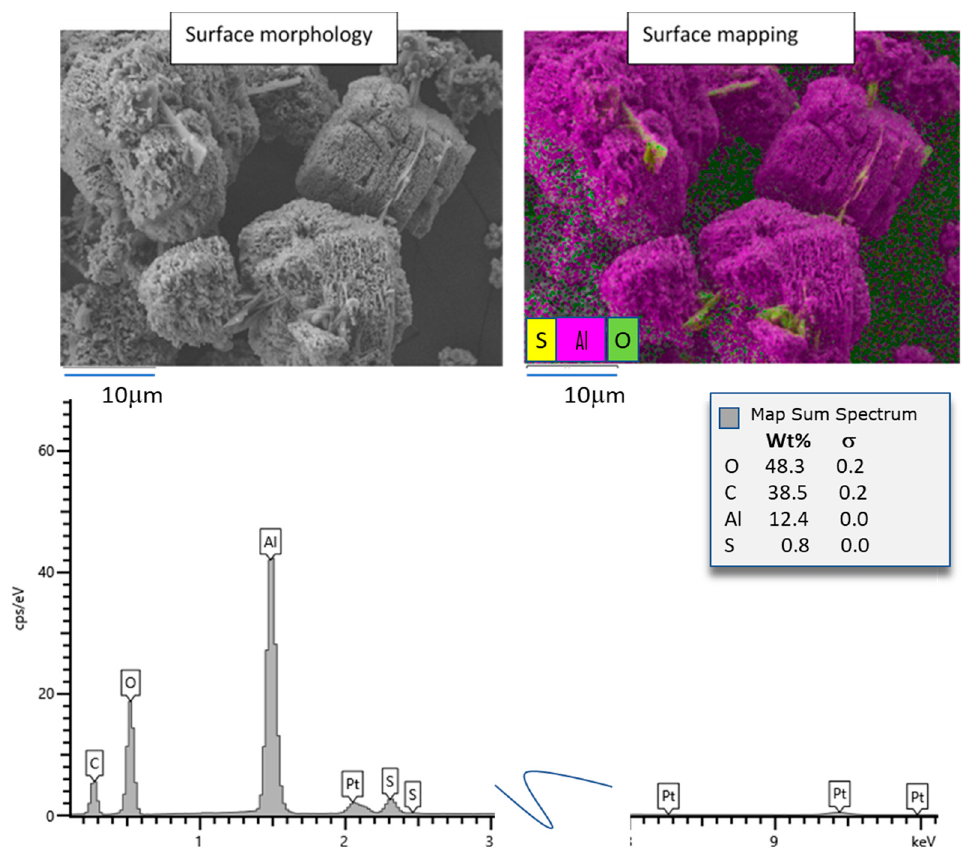
Figure 5. Chemical analysis of example Al2O3_PS sample using EDS mapping (detected C is background from mounting carbon tape, Pt is conductive coating) .